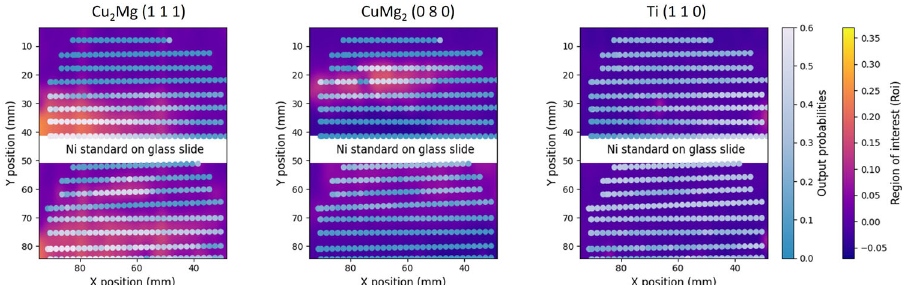
Fig. 6 The distribution of the XCA-generated phase probability, represented by round points in a gray-to-blue color scheme, overlayed on the interpolated intensity of the designated diffraction peak in the grid-scanned result, represented by a yellow-to-purple color scheme. The diffraction analysis was based on Cu 2 Mg (1 1 1), CuMg 2 (0 8 0), and Ti (1